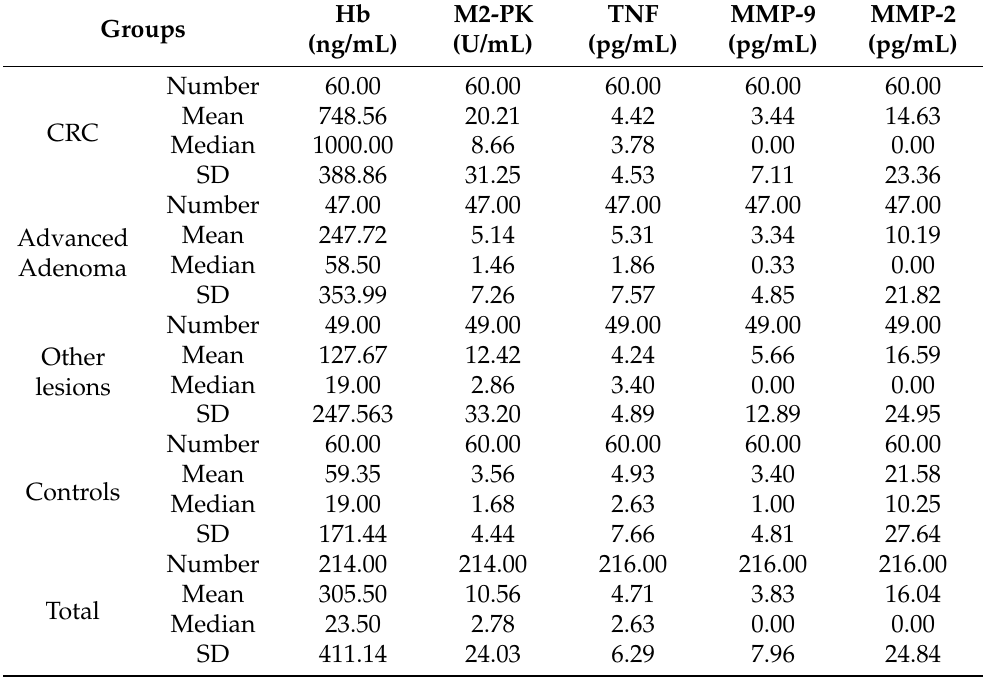
Figure 1. Biomarkers levels in stool samples of the different groups: ( A ) Matrix metalloproteinase (MMP)-2; ( B ) MMP-9; ( C ) Tumour necrosis factor-alpha (TNF- α ); ( D ) Haemoglobin (Hb); and ( E ) M2-pyruvate kinase (M2-PK). * Statistically significant differences ( p ≤ 0.05) of pairwise comparisons between groups. Table 2. Biomarkers levels in the different